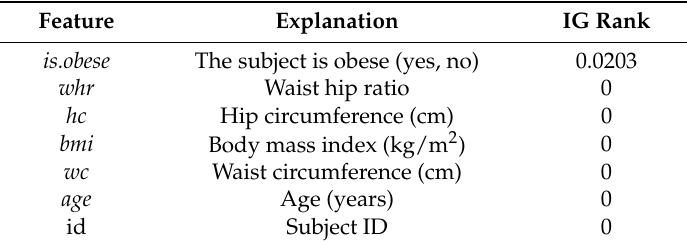
Table 2. The feature of dataset II and its Information Gain (IG)